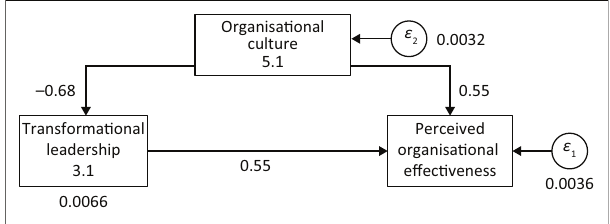
FIGURE 2: Mediation model.